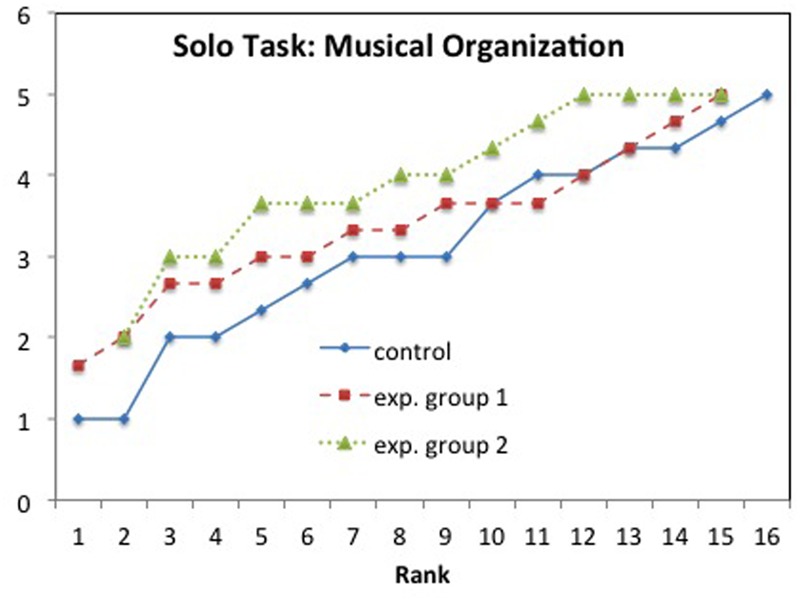
Solo task, Musical Organization: Mean values rank-ordered in each group.